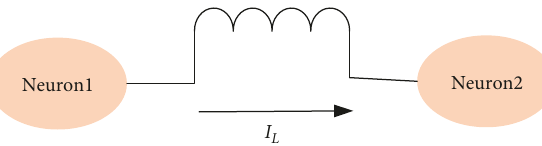
Figure 3: Two HR neuron models are connected by the induction coil to excite magnetic field